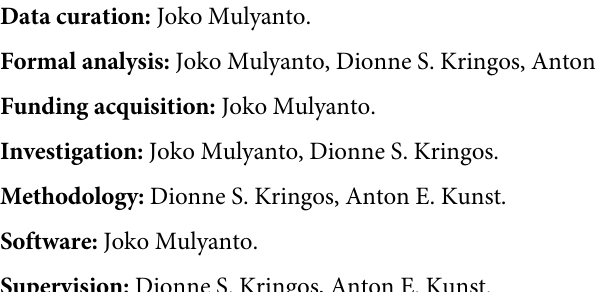
S1 Table. Association between food consumption and other consumption in IFLS 5 (2014). (PDF) S2 Table. Prevalence rate of healthcare utilisation for all type of healthcare, for total popu- lation and by income quintiles,